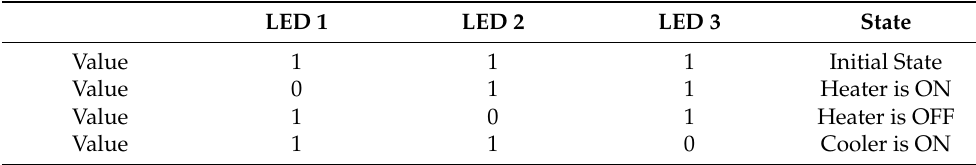
Table 3. States of